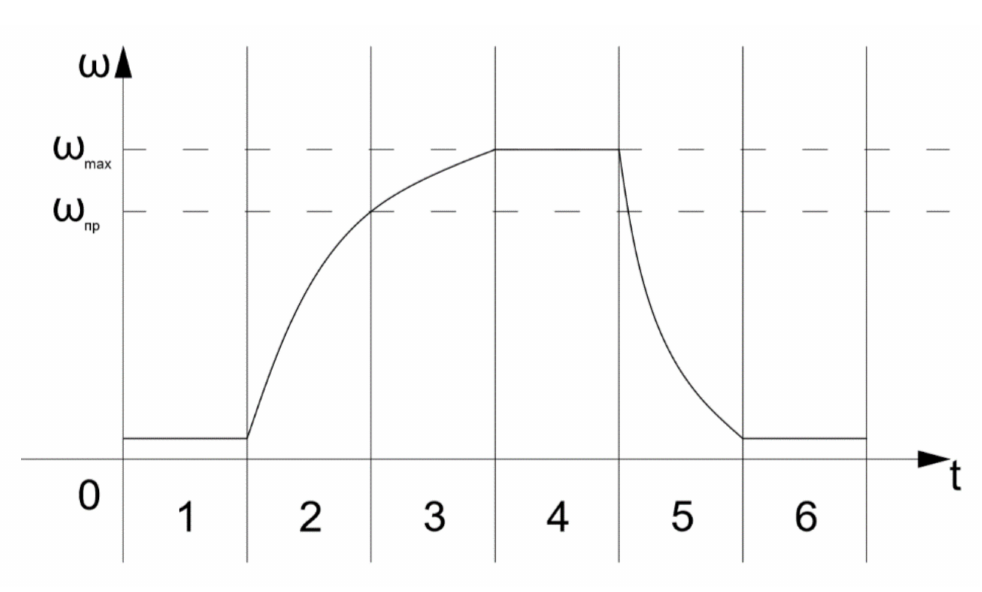
Figure 2. Complete operating schedule of the